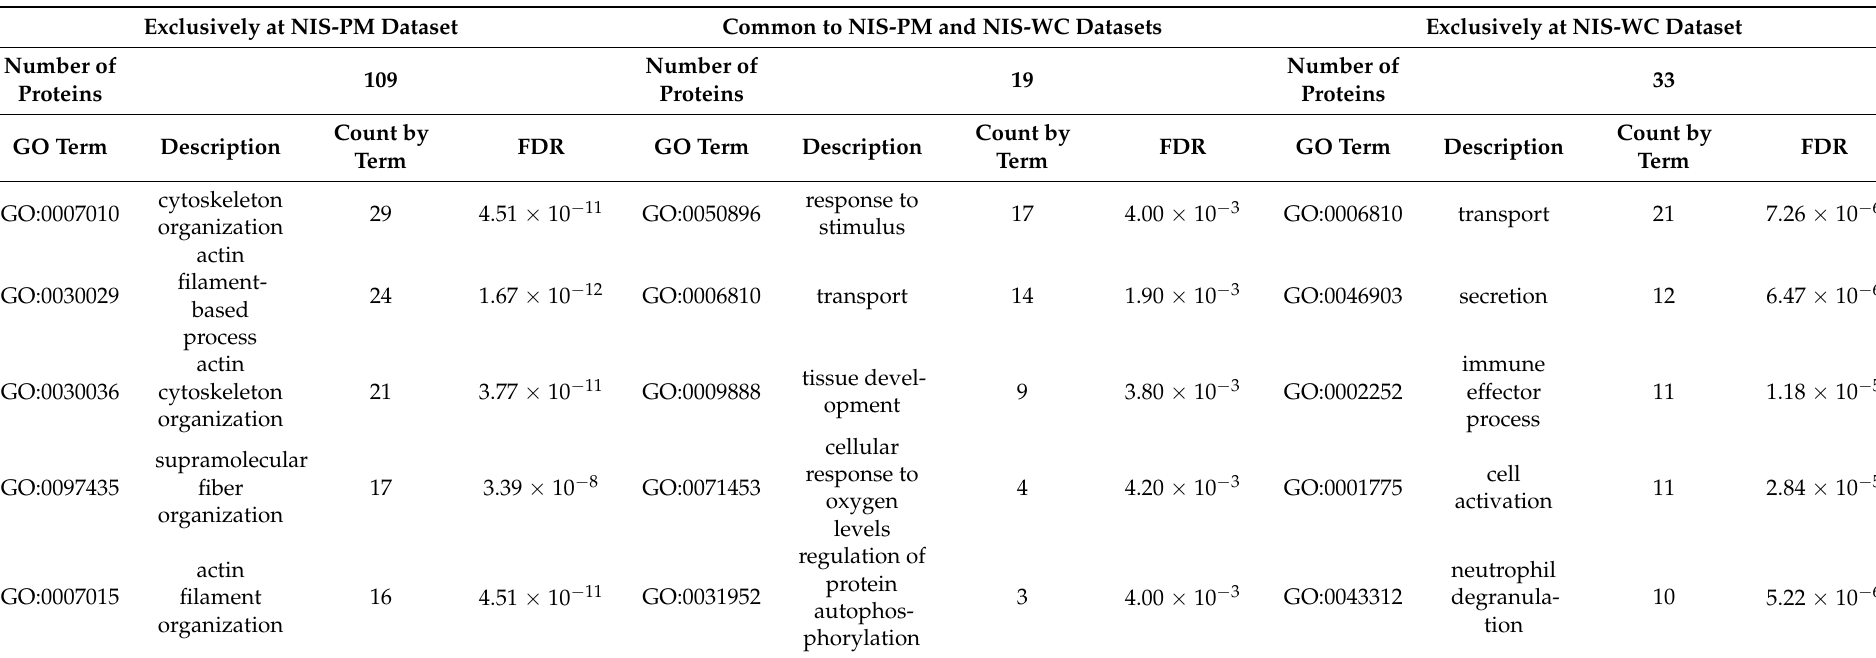
Table 1. Top five best-represented biological processes (BP) among the candidate NIS whole cell (WC) and plasma membrane (PM) interactors. Annotated GO-term enrichment analysis among the MS identified proteins with putative direct interactions with NIS. The analysis was performed using the STRING algorithm (https://string-db.org/, accessed on 3 May 2021) on the subsets of proteins exclusively detected in either the WC and PM datasets, and those present in both